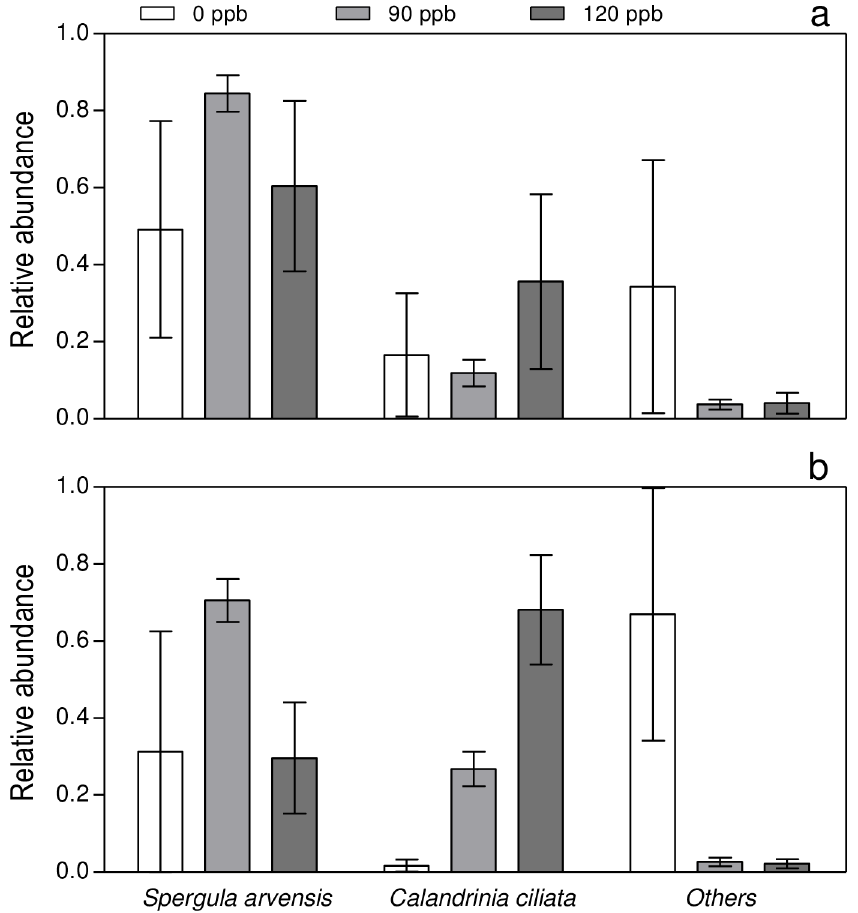
Fig 1. Relative abundance of Spergula arvensis , Calandrinia ciliata and other species in plant communities selected under different episodic concentrations of tropospheric ozone. Ozone concentrations in the open top chambers duringlong-termexposure were 0 ppb (white bars), 90 ppb (grey bars) and 120 ppb (dark bars). Data represents species abundances duringthe first (a) and second (b) year of experiment after originalsoil seed bank was transplanted to a common natural field environment. Relative abundance for each plant species was calculatedas the summed abundancesof each plant speciesfor a particular year/total numberof seedlingsrecorded in the plot (n = 3). Error bars represent standarderror. Year a ANOVA